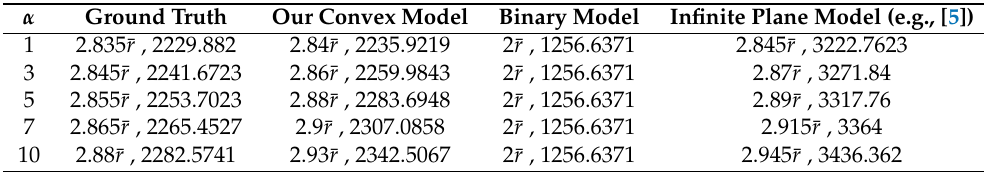
Table 1. Comparison of D m and ¯ C values with n =